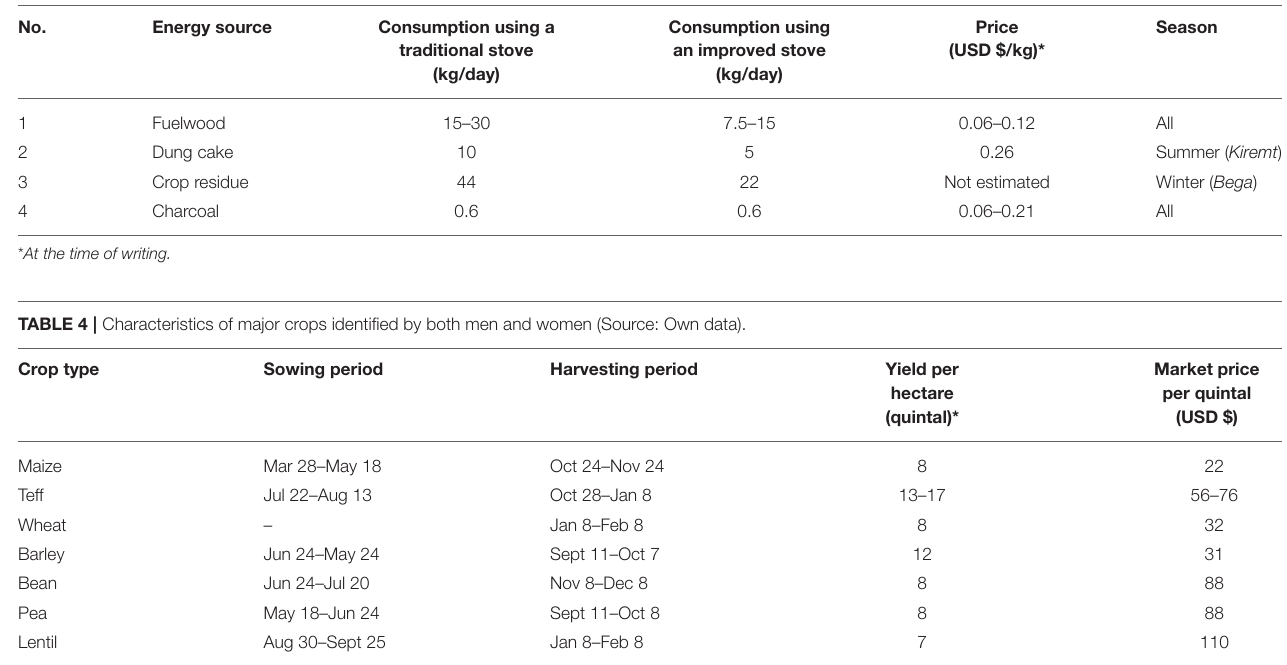
TABLE 3 | Estimated daily household energy consumption by stove type (Source: Own data).